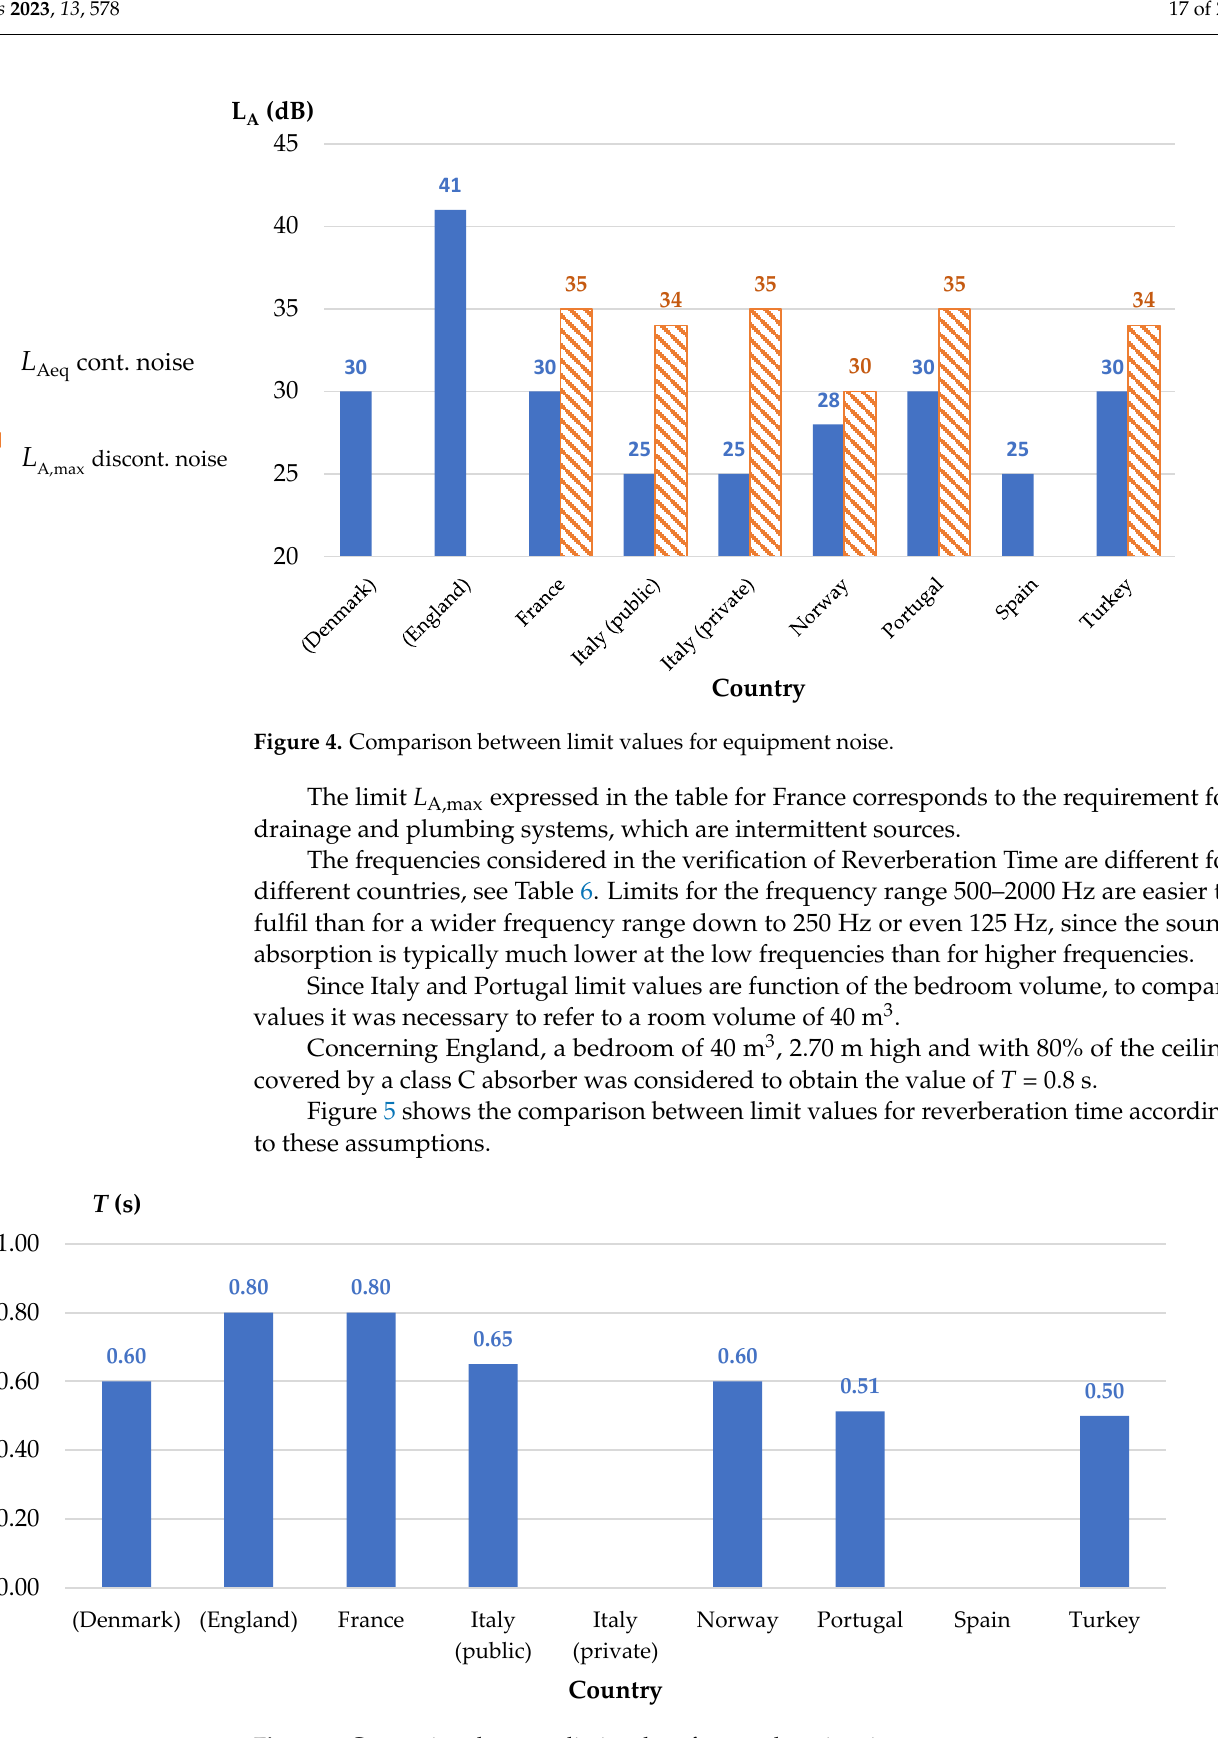
Figure 5. Comparison between limit values for reverberation